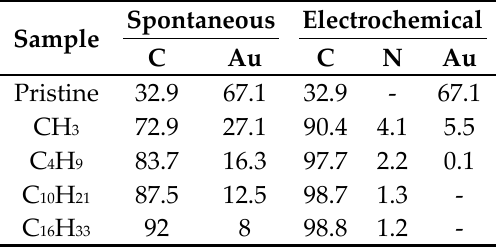
Table 1. Surface atomic element concentrations from XPS measured for pristine, grafted by ADTs.